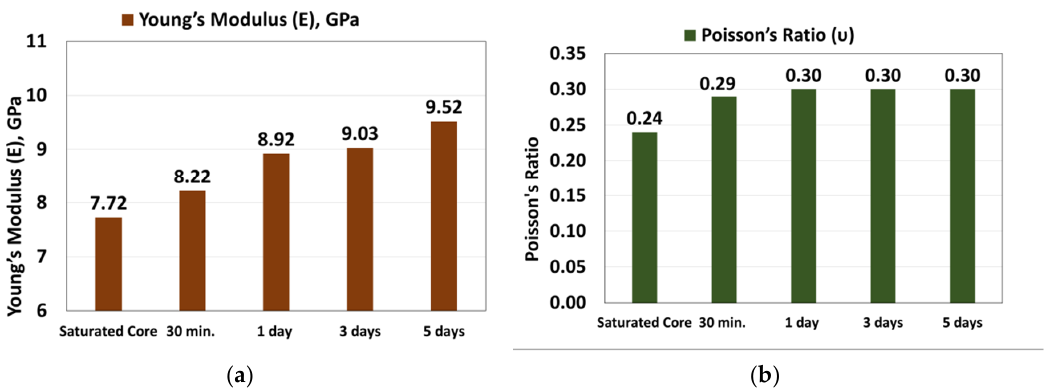
Figure 4. Exposure time effect on ( a ) Young`s modulus and ( b ) Poisson’s ratio.